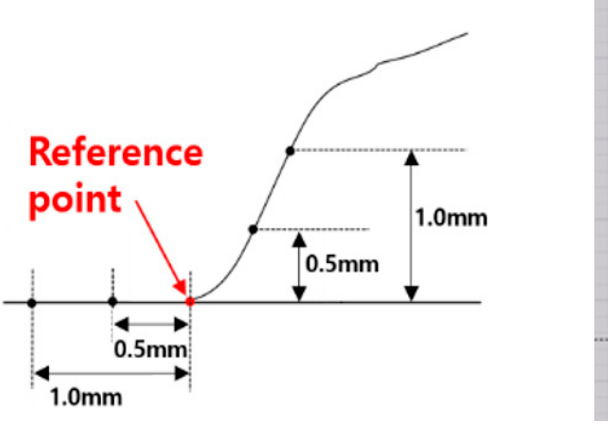
11 of 25 Figure 17. Schematic diagram of the trough depth measurement. Minimum Radius at the Toe Area